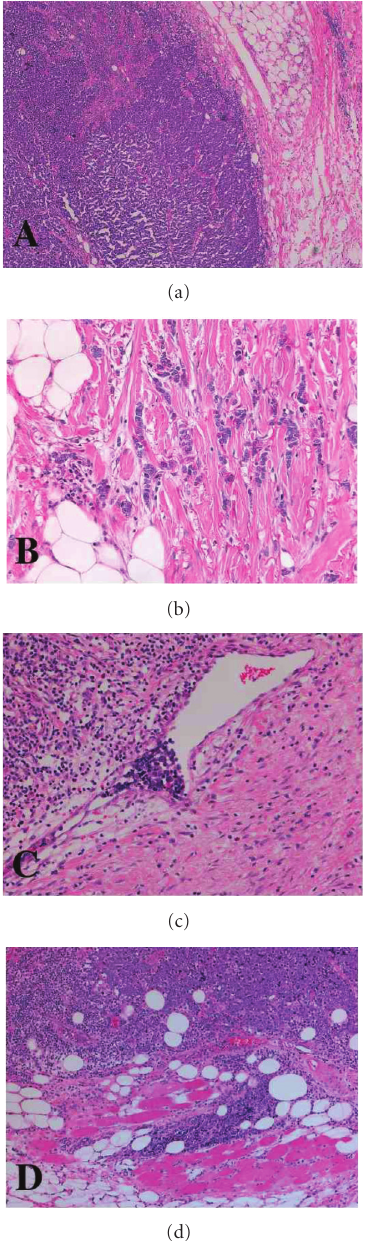
Figure 2: Microscopic appearance of Merkel cell carcinoma. Haematoxylin and eosin staining of a MCC section. (a) Nodular growth pattern. (b) Infiltrative growth pattern. (c) Lymphovascular invasion. (d) Skeletal muscle